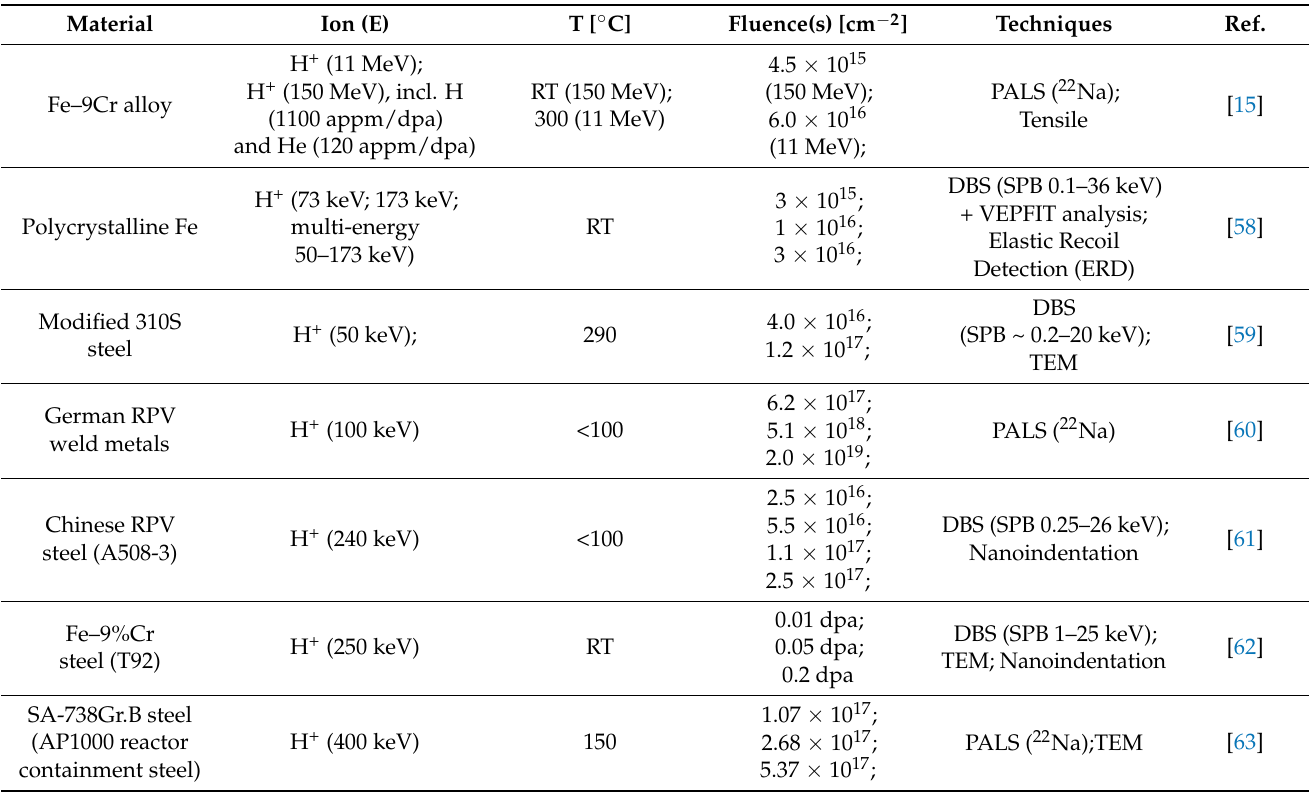
Table 2. Selected PAS studies published on proton irradiation of nuclear structural